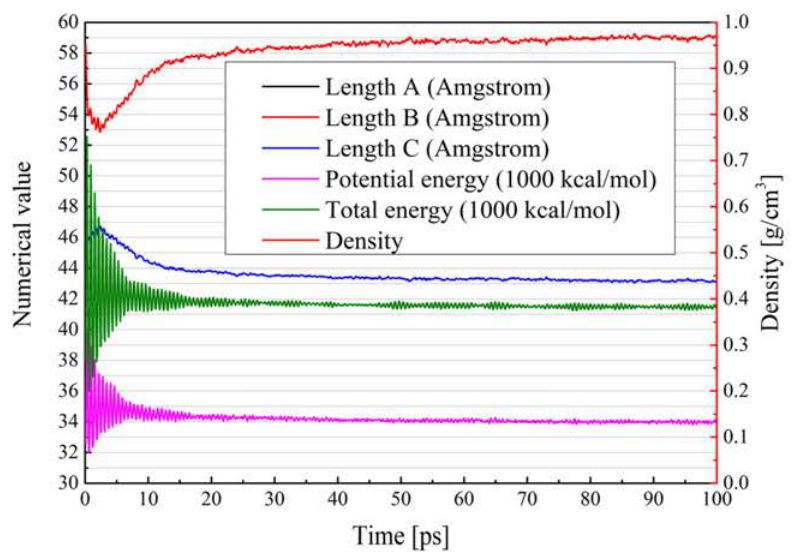
Figure 6. Variation of system parameters during molecular dynamics